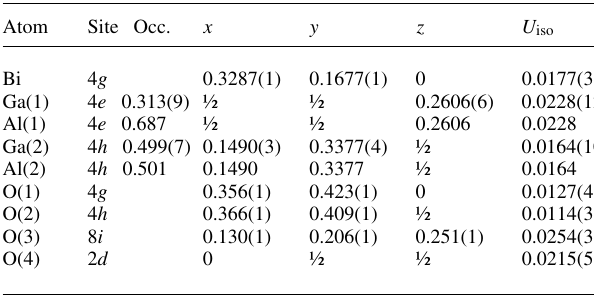
Table 2. Atomic coordinates and displacement parameters (in Å 2 )